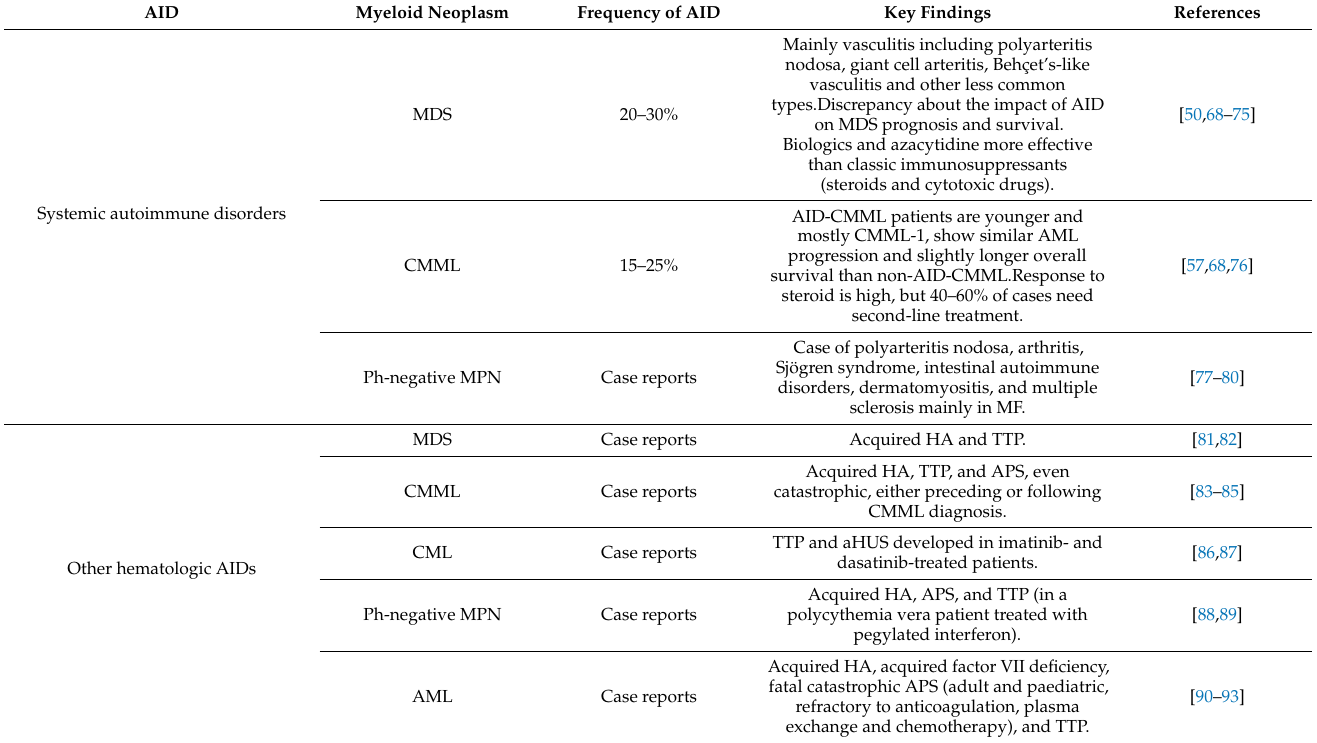
Table 4. Autoimmune diseases (AID) complicating myeloid